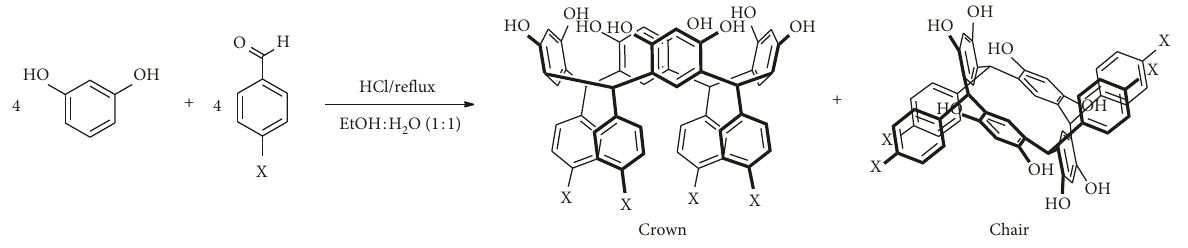
Figure 1: Synthesis of aromatic